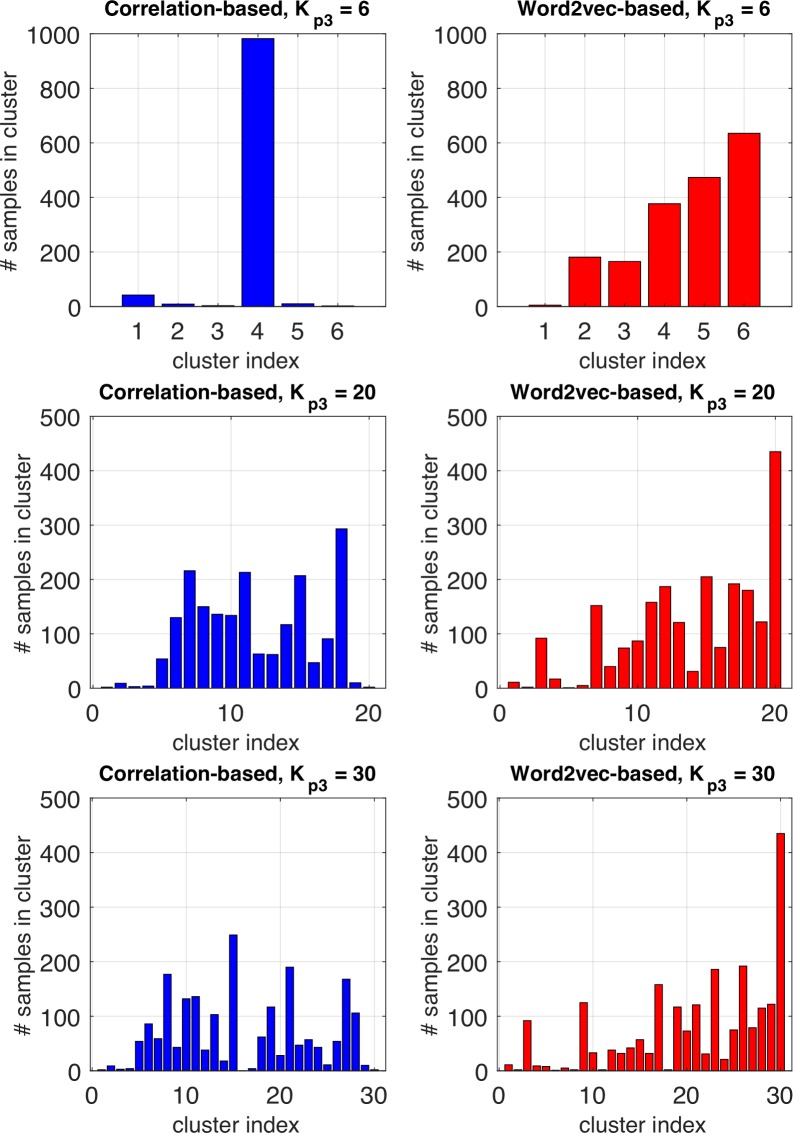
Distribution of samples with respect to Kp3.